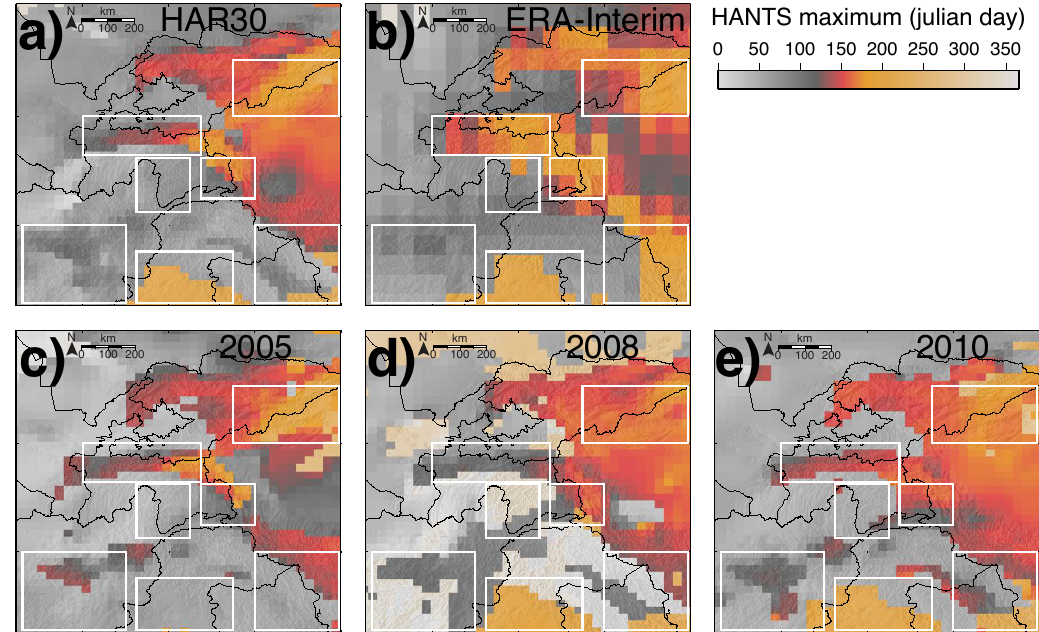
Figure 5. HANTS timing results for ( a ) the 12-year period of HAR30 and ( b ) the 35-year period of ERA-Interim for comparison. Timing results for the individually-analyzed years ( c ) 2005, ( d ) 2008 and ( e ) 2010. White bounding boxes correspond to subdivided study sites from Figure